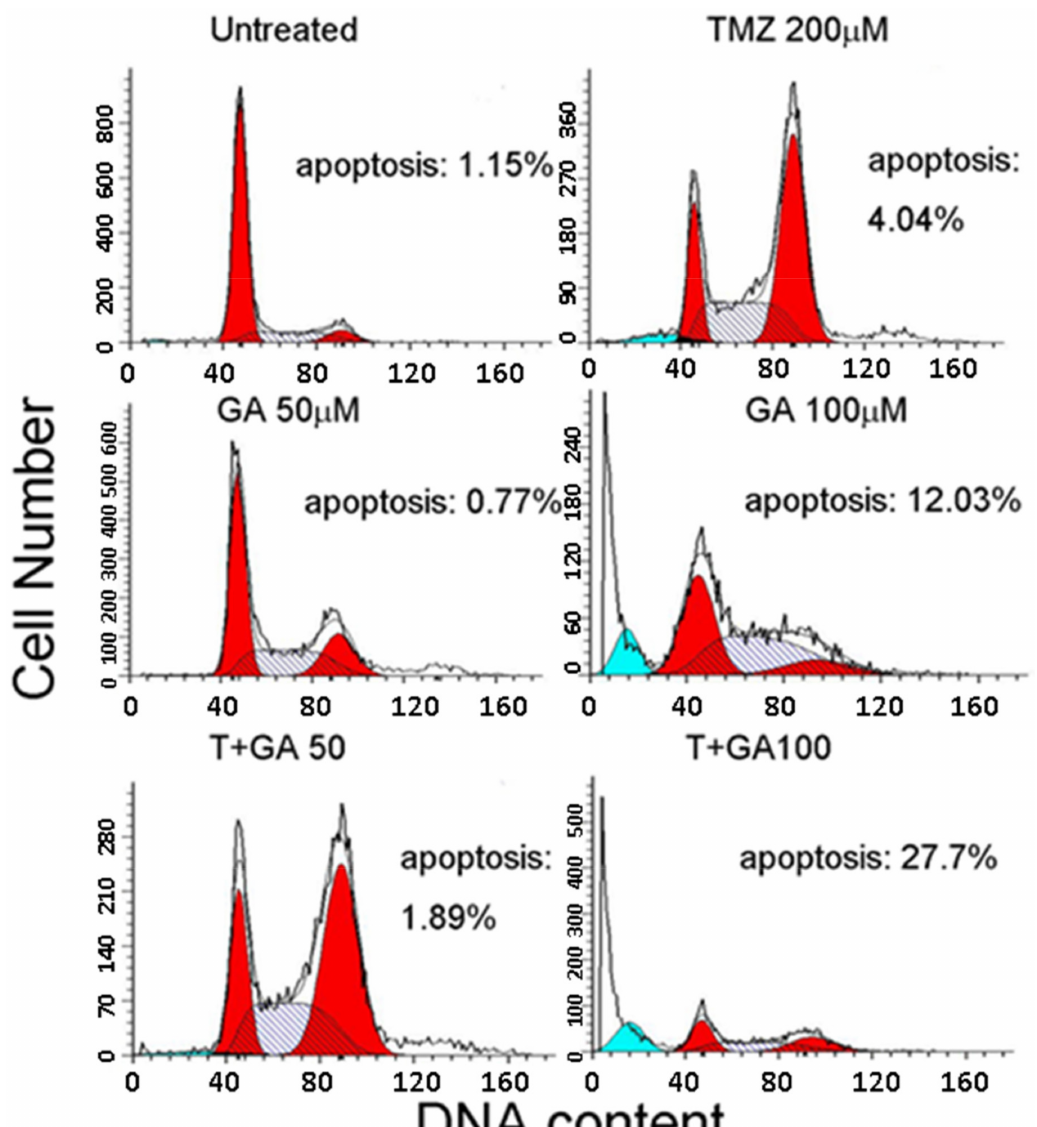
Figure 3. DNA damage analysis of the treatment with TMZ alone, Ga alone, or Ga/TMZ combination in U87MG glioma cell line. U87MG cell line was incubated with several concentrations of TMZ (200 µ M), Ga (50 and 100 µ M) or Ga/TMZ co-treatment for 48 h. The percentages of Sub G1 phase indicated that the apoptosis was evaluated by PI staining and flow cytometer. The red peak on the left represents the area of G1 phase. The red peak on the right represents the area of G/M phase. The backslash area in the middle represents the area of S phase. The light blue area in the left represents the area of